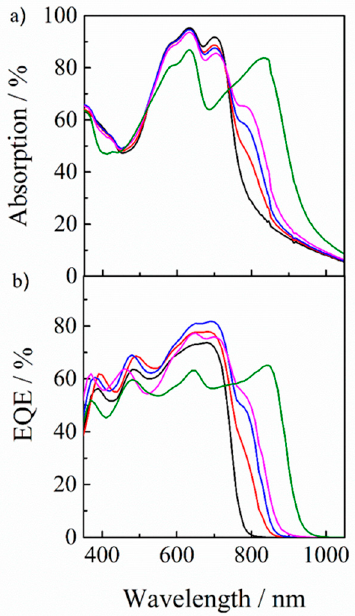
Figure 5. ( a ) UV-visible absorption and ( b ) EQE spectra of PBDB-T/IT-M/Y6 ternary blend films with different blend ratios: 1 : 1 : 0 (black line), 1 : 0.9 : 0.1 (red line), 1 : 0.8 : 0.2 (blue line), 1 : 0.7 : 0.3 (purple line), and 1 : 0 : 1 (green line).